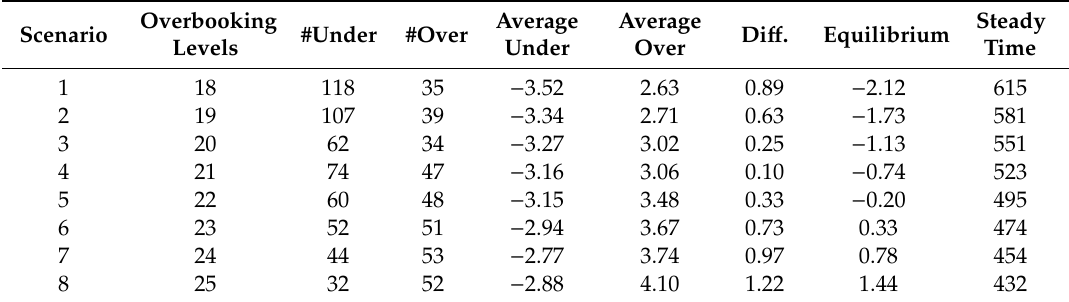
Table 4. The level of overbooking increases, the time to work through the queue is reduced, and as a result, the reference time sample is reduced for the calculation of the number of visits above (#Over) or below (#Under) the expected availability. Average Average Overbooking #Under #Over Under Levels